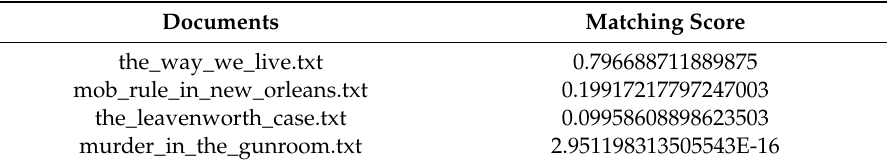
Table A4. Top Docs for TermQuery: prison, kill, and